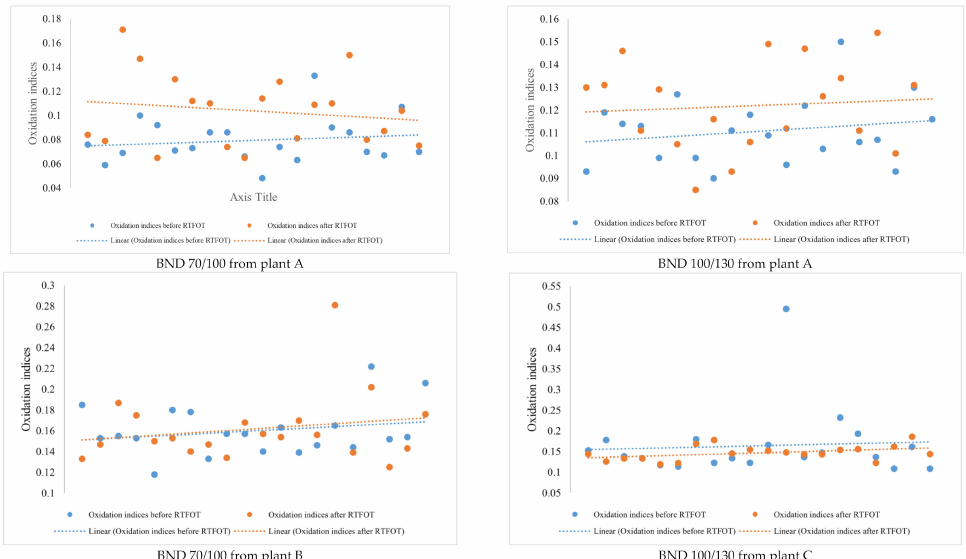
Figure 10. Comparison between the oxidation indices before and after RTFOT by plant and binder samples’